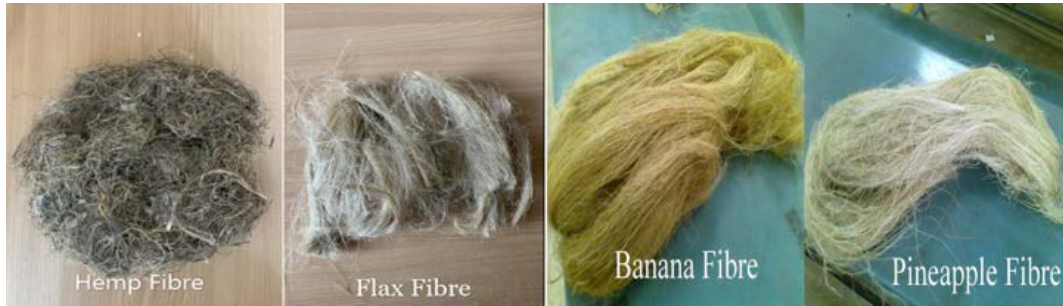
Figure 1. Fibers used for the fabrication.